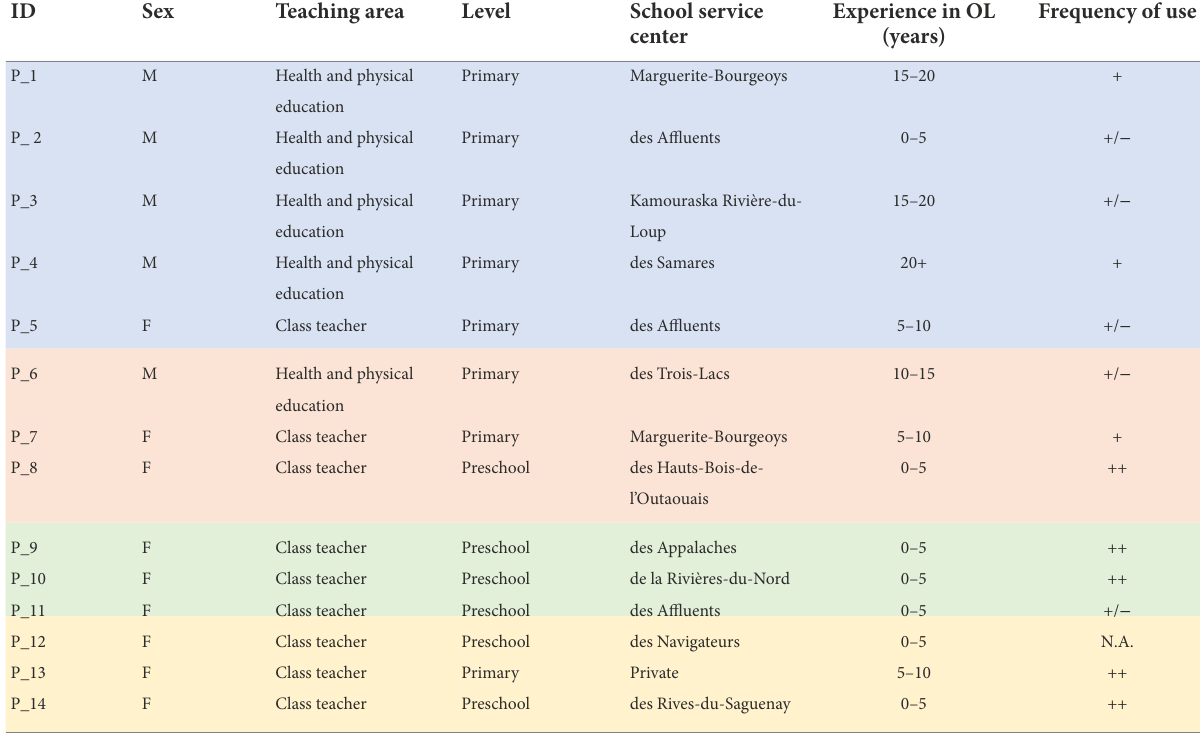
TABLE 3 Profile and characteristics of participating teachers.